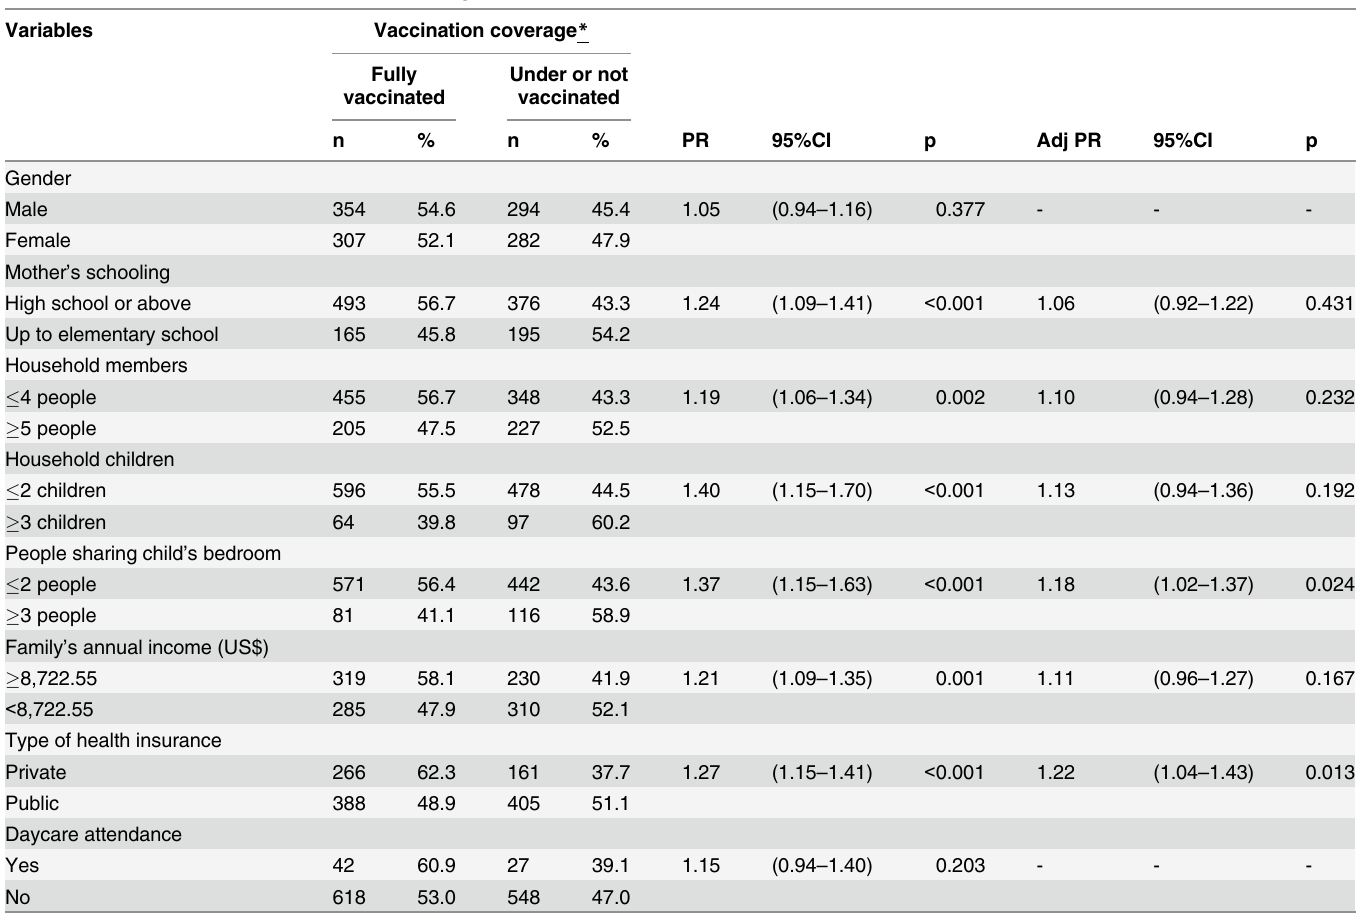
Table 2. Variables associated with PCV10 coverage, 6 to 8 months after its introduction.